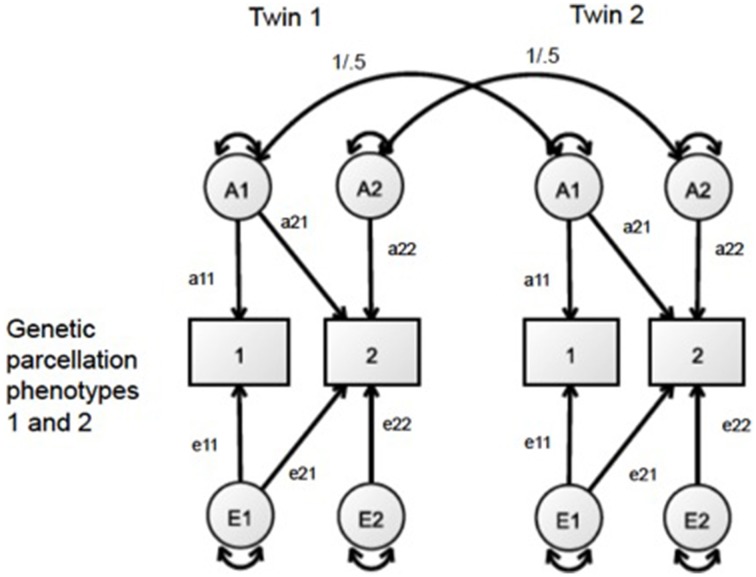
Bivariate AE Cholesky framework, in which the covariance of two phenotypes is decomposed into genetic (A) and unique environmental (E) variance.